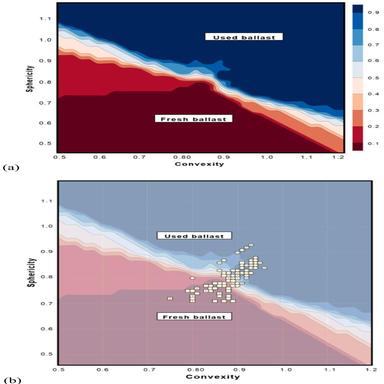
Comparison differences in the segmentation results between fresh and used ballast.